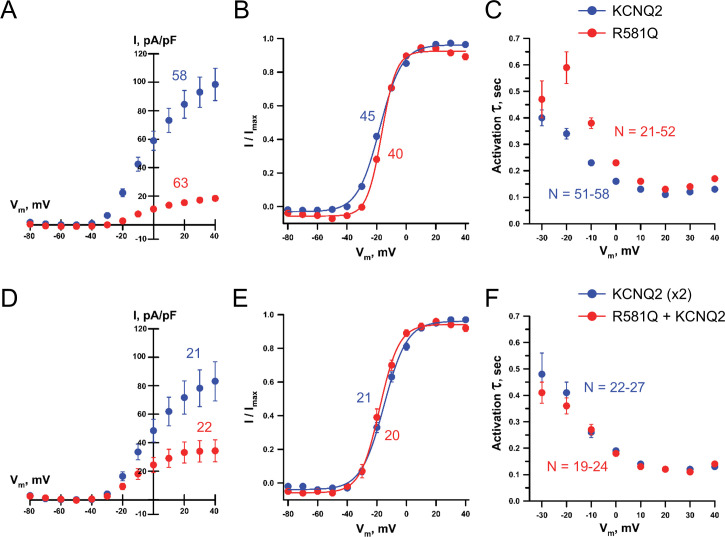
Whole-cell voltage-clamp analysis of KCNQ2 R581Q.Whole-cell currents were recorded using automated patch clamp from KCNQ3-stably expressing CHO-K1 cells transiently transfected with either. (A–C) wild-type KCNQ2 or R581Q in the homozygous KCNQ2 configuration or (D–F) co-transfected with R581Q and wild type KCNQ2 (heterozygous KCNQ2 configuration). (A,D) Average XE-991-sensitive whole-cell current-voltage relationship, (B,E) voltage-dependence of activation V½ and (C,F) time-constant of activation (τ). In the homozygous configuration, compared to wild type KCNQ2, R581Q exhibited a 1.31 ± 0.4 mV shift (t test: p=0.049) in the voltage-dependence of activation V½ (B) and a slower activation time constant in the −20 to +20 mV range (t test: p-values<0.0001; C). In the heterozygous configuration, compared to wild type KCNQ2 (x2), R581Q + KCNQ2 exhibited a −3.45 ± 1.22 mV shift (t test: p=0.043) in the voltage-dependence of activation V½ (E) with no difference in the activation time constant (F). Number of cells analyzed is displayed within the figure. Values displayed are mean ± SEM.